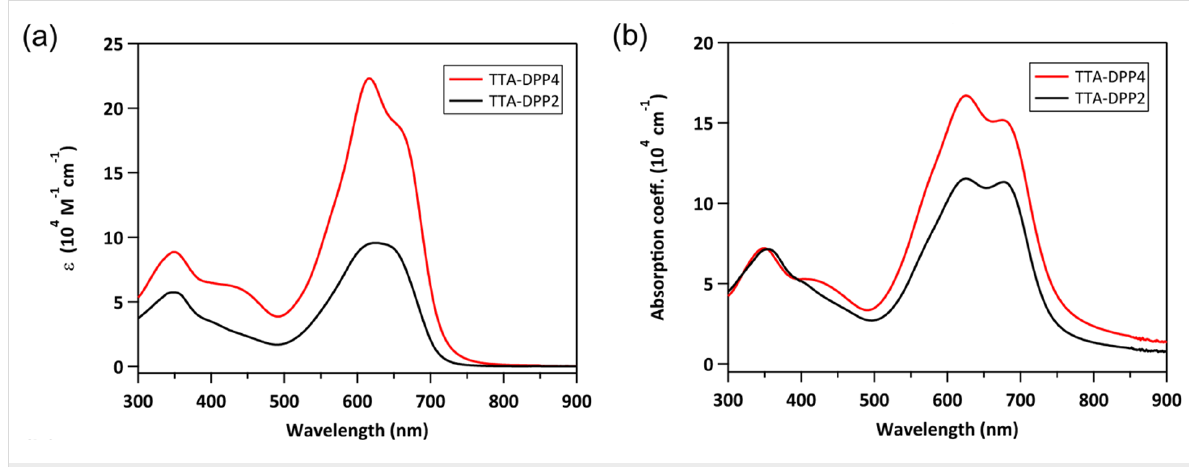
Figure 4: UV–vis absorption spectra of TTA-DPP4 (red) and TTA-DPP2 (black) in (a) chloroform solutions and (b) thin films.